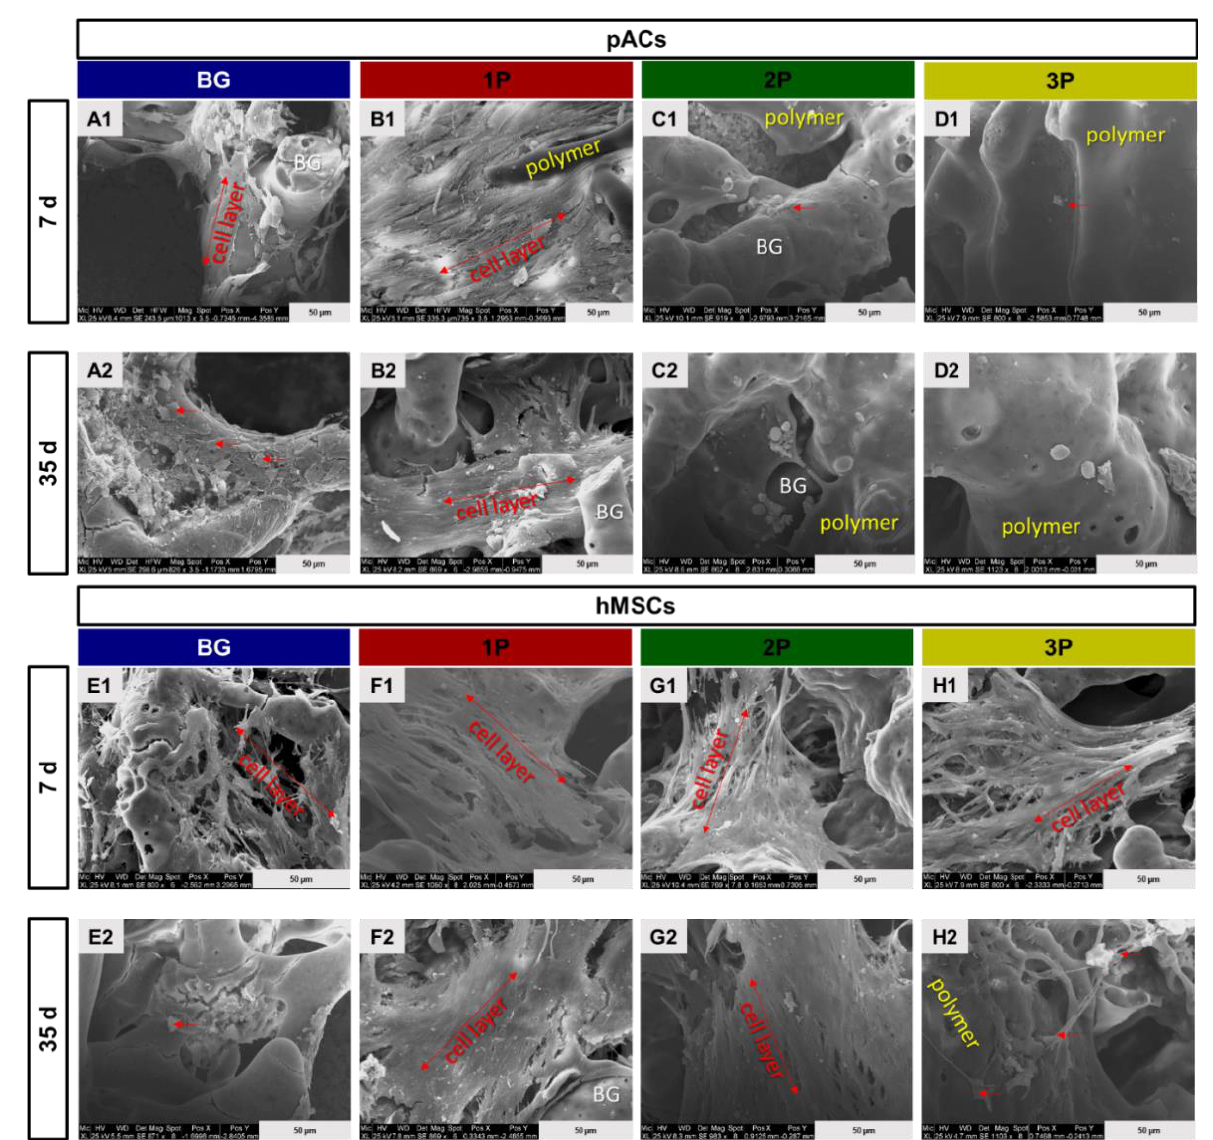
Figure 7. Scanning electron microscopy (SEM) of colonized scaffolds. Representative images of the morphology not only of the pACs ( A1 – D2 ) on the scaffolds after 7 days (d) ( A1 – D1 ) and after 35 d ( A2 – D2 ) but also of hMSCs ( E1 – H1 ) on the scaffolds after 7 ( E1 – H1 ) and 35 d ( E2 – H2 ) in dynamic culture. The pure bioactive glass (BG, blue), single (1P, red), twofold (2P, green) and threefold PLGA infiltrations (3P, yellow). Scale bar: 50 µm. pACs = porcine articular chondrocytes, hMSCs = human mesenchymal stem cells, BG = bioactive glass. Single cells are marked with red arrow and cell layers are marked by double headed arrows.